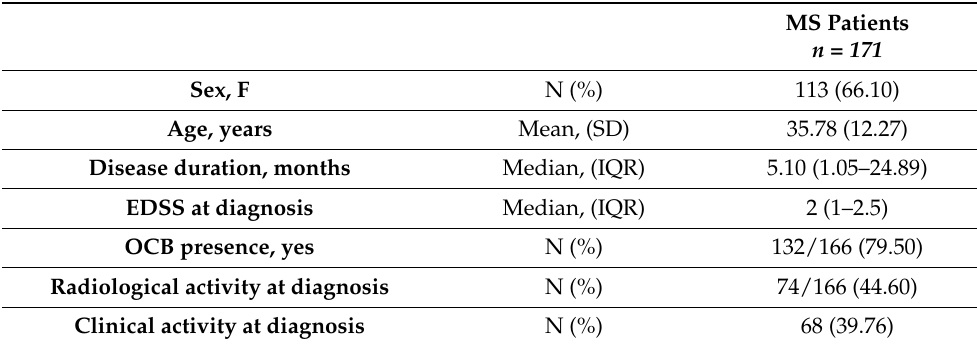
Table 1. Demographic and clinical characteristics of RR-MS